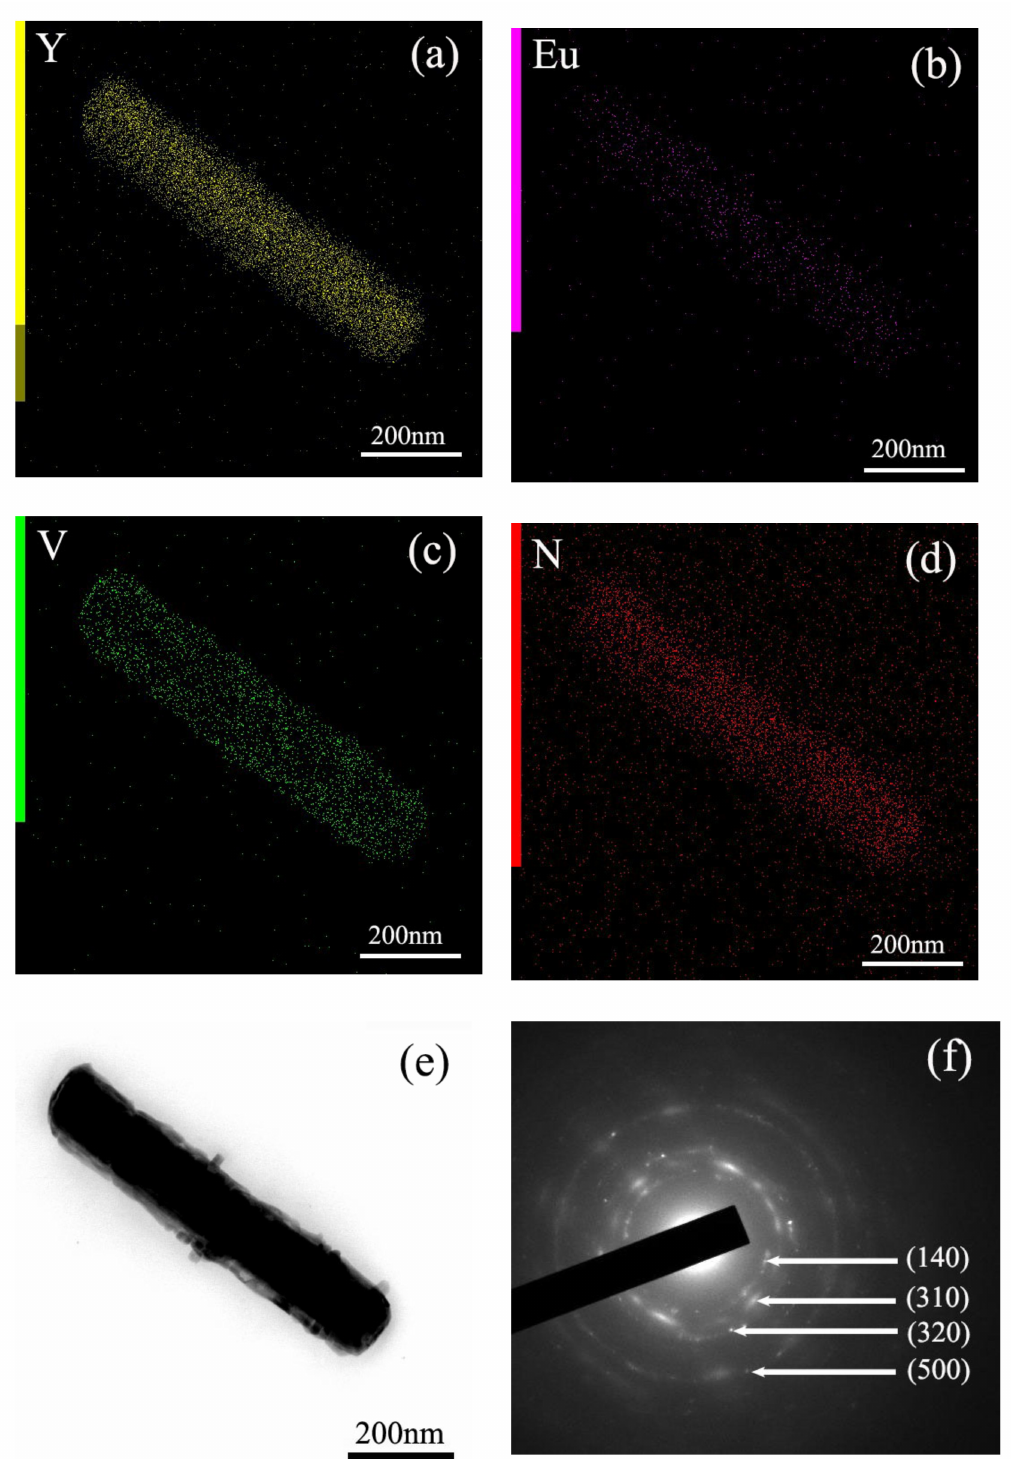
Figure 6. ( a – d ) Elemental mapping, ( e ) TEM image, and ( f ) SAED for